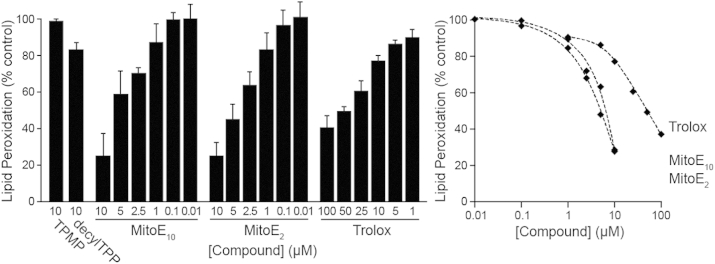
Prevention of lipid peroxidation in rat liver mitochondria by MitoE2, MitoE10 and Trolox.